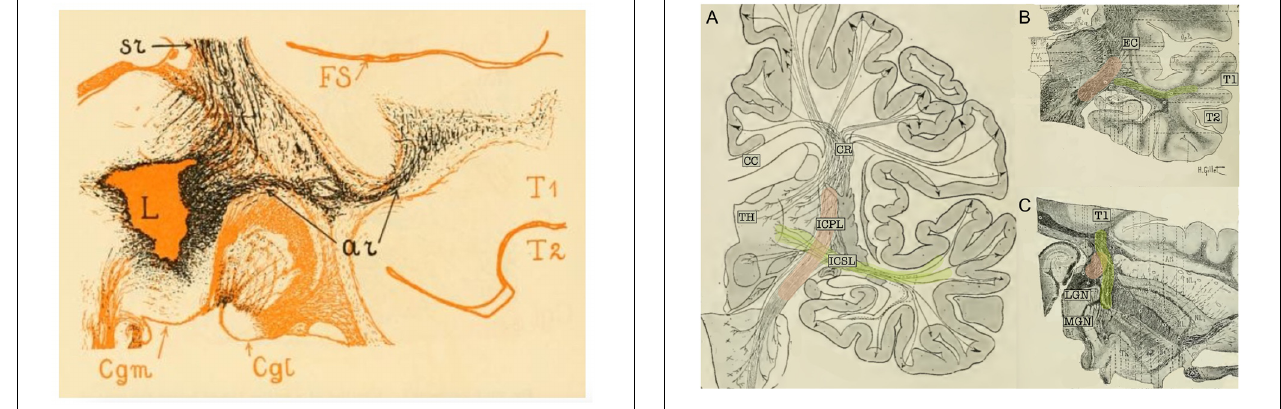
FIGURE 2 | The image shows the acoustic radiation fibers in the rhesus monkey. The lesion (L) was located in the posterior thalamus. From here we can see numerous thalamocortical (or somato sensory) (sr) and auditory (ar) fibers emerging. The sr and the ar fibers form a system of which the ar occupies the most ventral position. The acoustic radiation occupies the upper half of the white matter of the superior temporal convolution (T1) and enters the cortex of the lower wall of the Sylvian fissure (FS). The level of this figure is immediately behind the posterior extremity of the lentiform nucleus; the entire length of the acoustic radiation is visible here. Cgm, medial geniculate nucleus; Cgl, lateral geniculate nucleus (adapted from Polyak, 1932; https://archive.org, public domain).